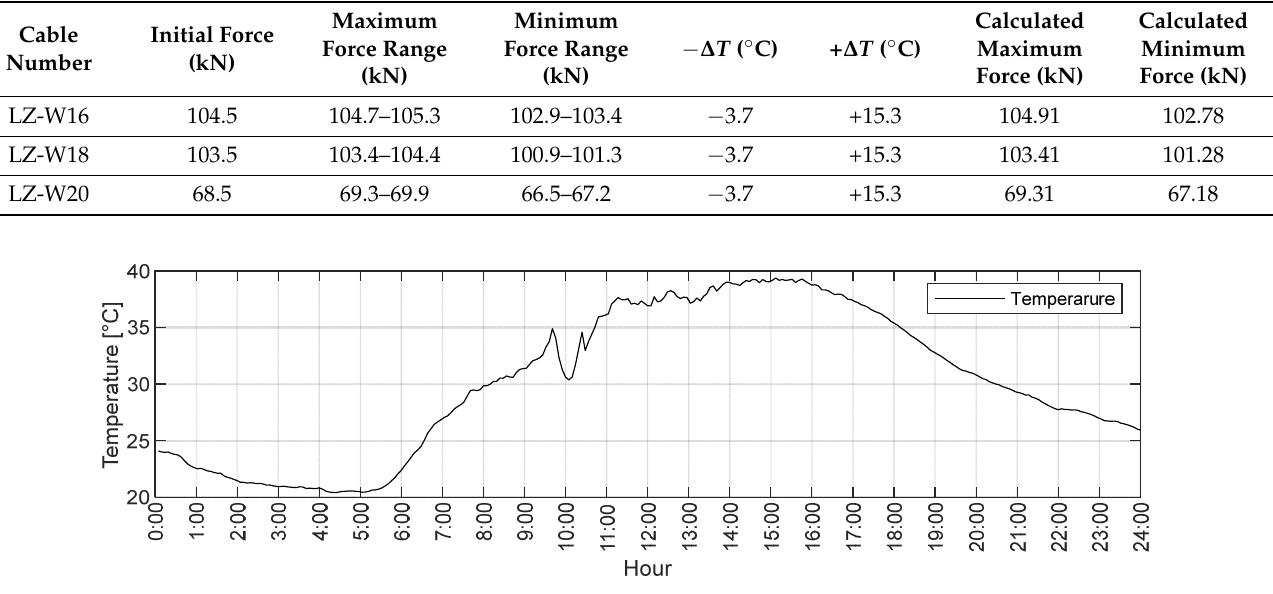
Figure 9. Daily strands temperature change (1 August 2017).